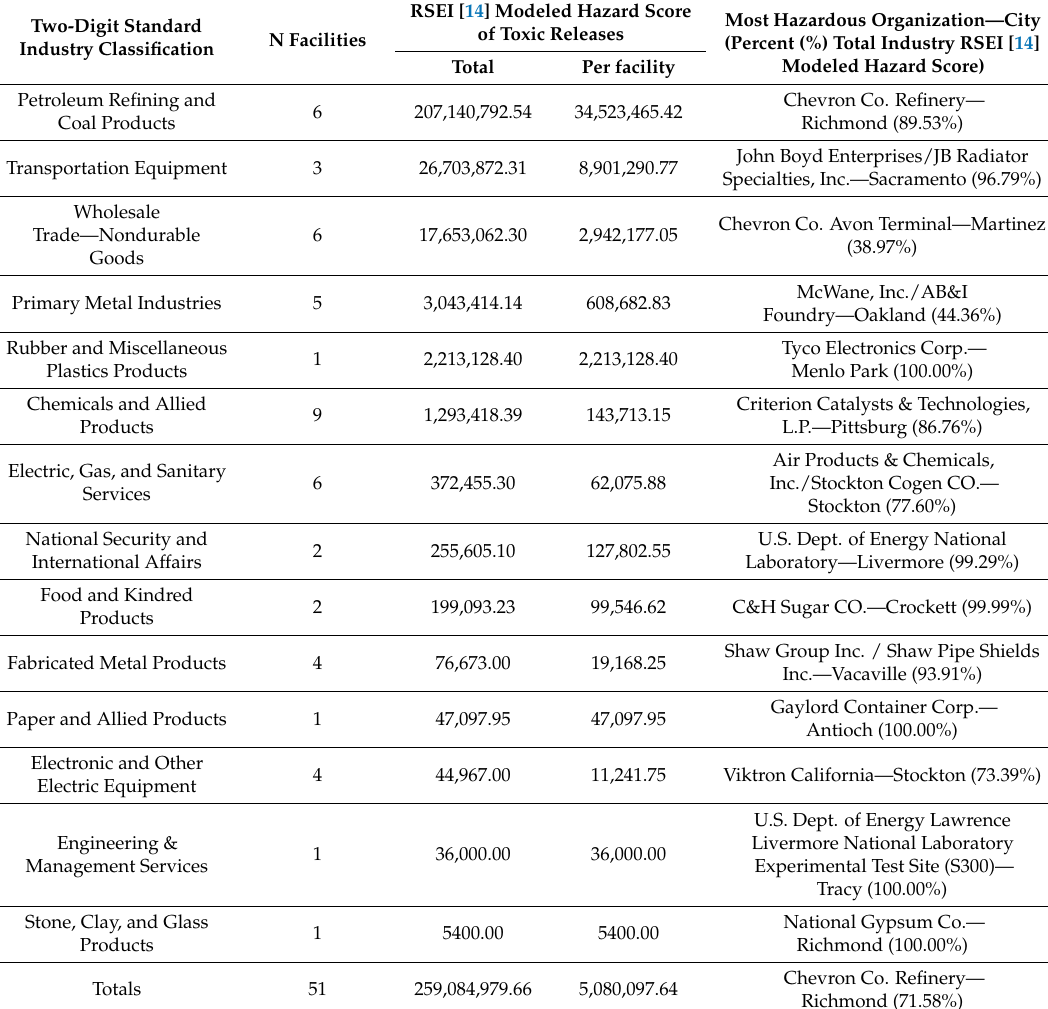
Table 3. Surface water toxic releases by industry classification and Risk-Screening Environmental Indicators (RSEI) [14] modeled hazard score, 2000 −